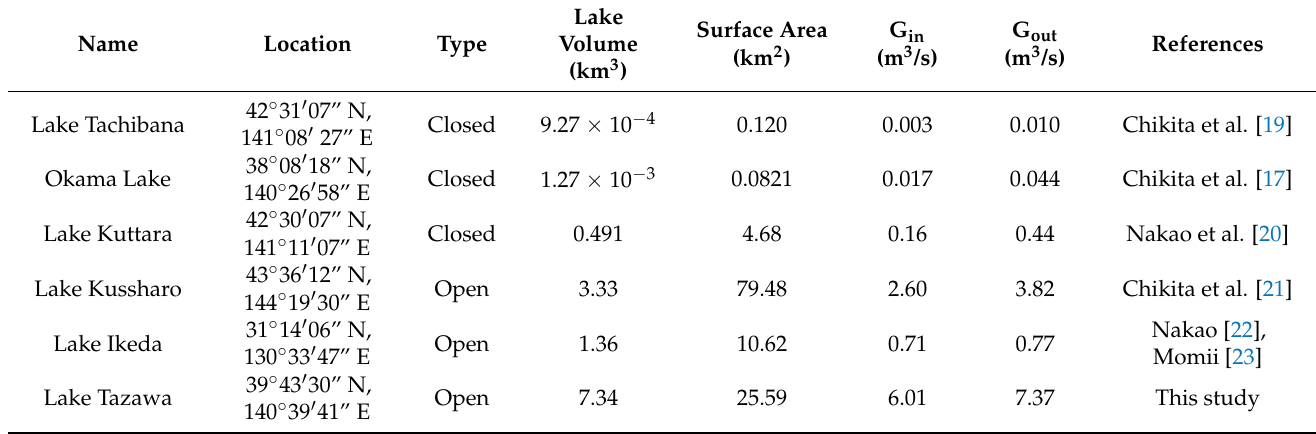
Table 4. Groundwater inflow G in and groundwater outflow G out in Japanese caldera or crater lakes, previously evaluated from the estimates of the hydrological budget and/or chemical budget. Their location, type, lake volume and lake surface area are also